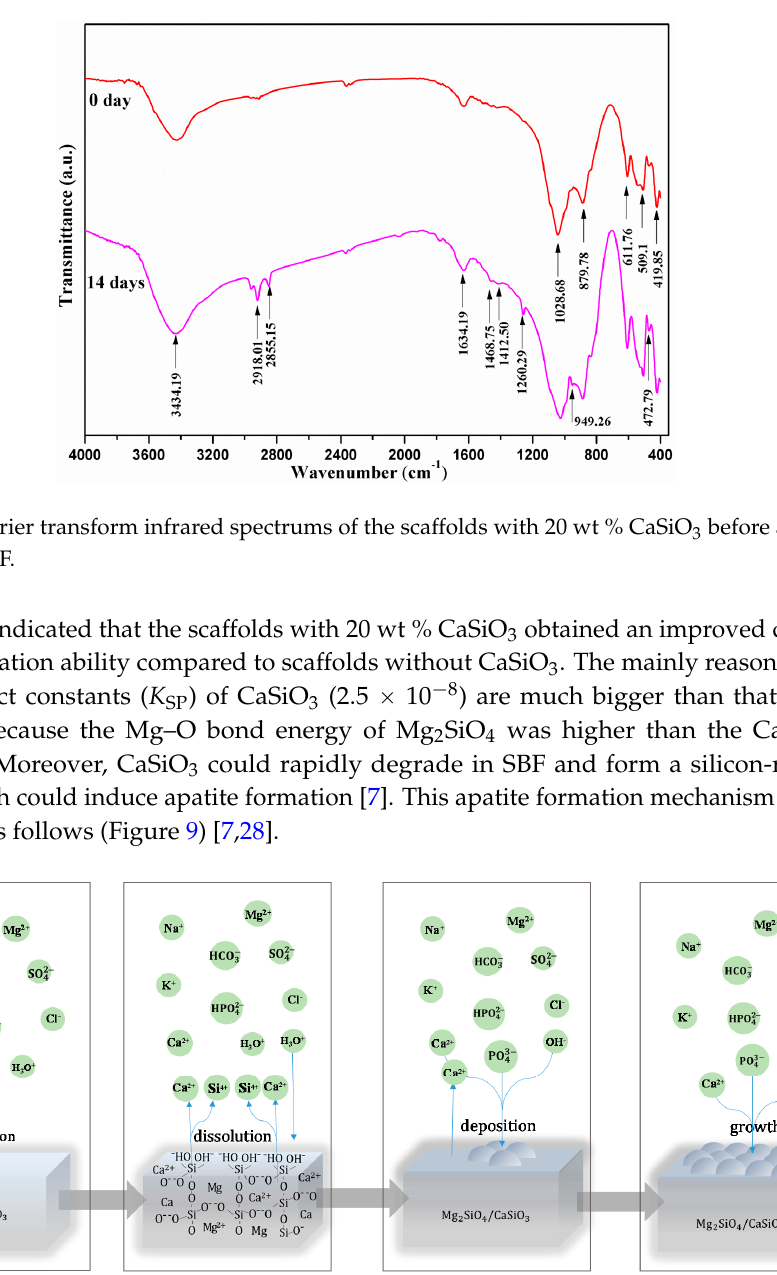
Figure 9. Mechanism of bone-like aspatite formation on the scaffolds with CaSiO 3 in SBF.